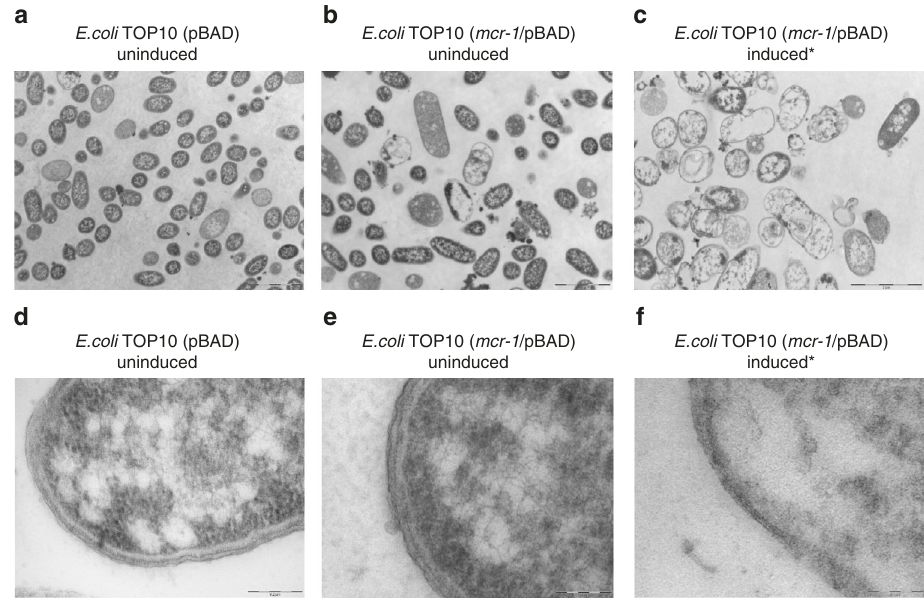
Fig. 3 TEM micrographs of untreated and treated E.coli . In a and b , TEM micrographs of untreated control cells ( E. coli TOP10 with pBAD minus mcr-1 , and E. coli TOP10 ( mcr-1 /pBAD) without L -arabinose induction, respectively); both cells are intact with a well-de fi ned inner and outer membrane, and showed a highly homogeneous electron density in cytoplasm region ( d and e ). c TEM micrographs of mcr-1 overproducing cells; the damaging outer membrane and some completely lysed cells were observed ( f )